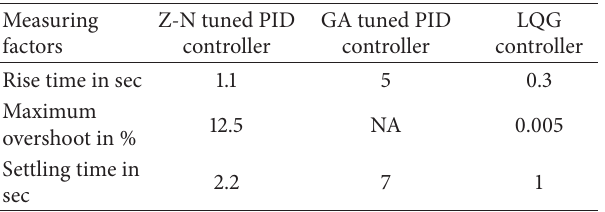
Figure 12: 𝜙 versus 𝑎 𝑦 error transient response for different controllers. Table 2: Results of Z-N tuned PID controller, GA tuned PID controller, and LQG controller.